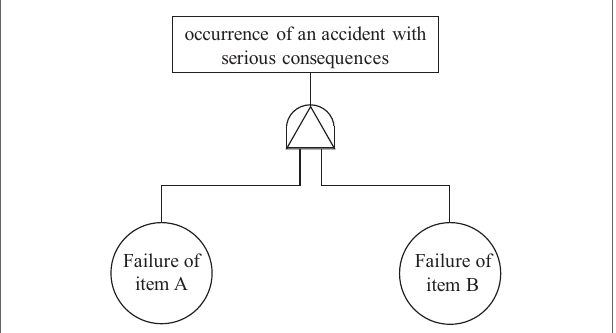
FIGURE 2 | Fault tree representation of the system considered